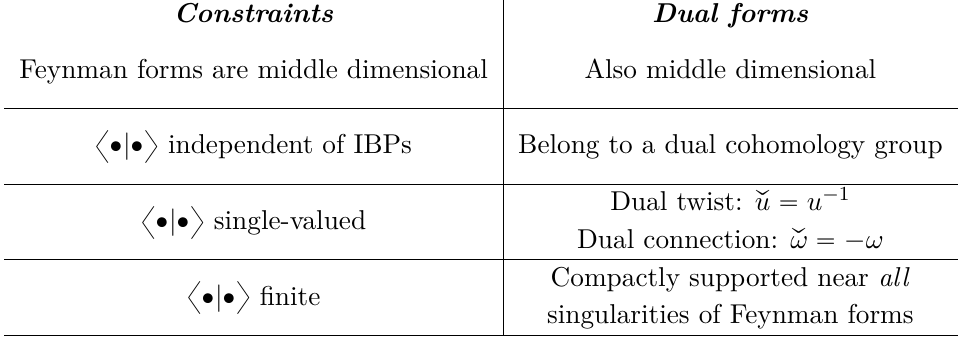
Table 1 . Table summarizing the properties of dual forms and why they are